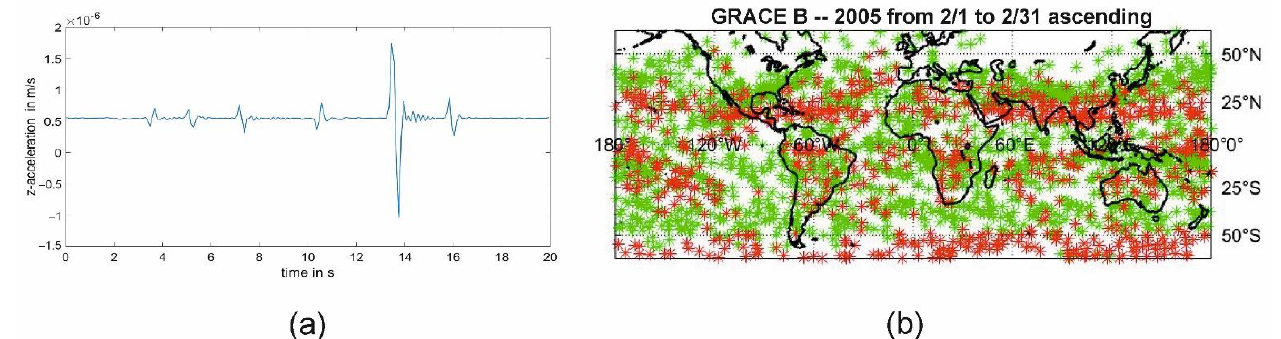
Figure 7. Twangs often occur as multiples with a changing sign. Left, a sequence of twangs on GRACE B is shown ( a ). Looking at the geographical distribution of positive (green) and negative (red) twangs (right), the different types form different bands, where high-amplitude negative twangs can be separated from high-amplitude positive twangs ( b ).